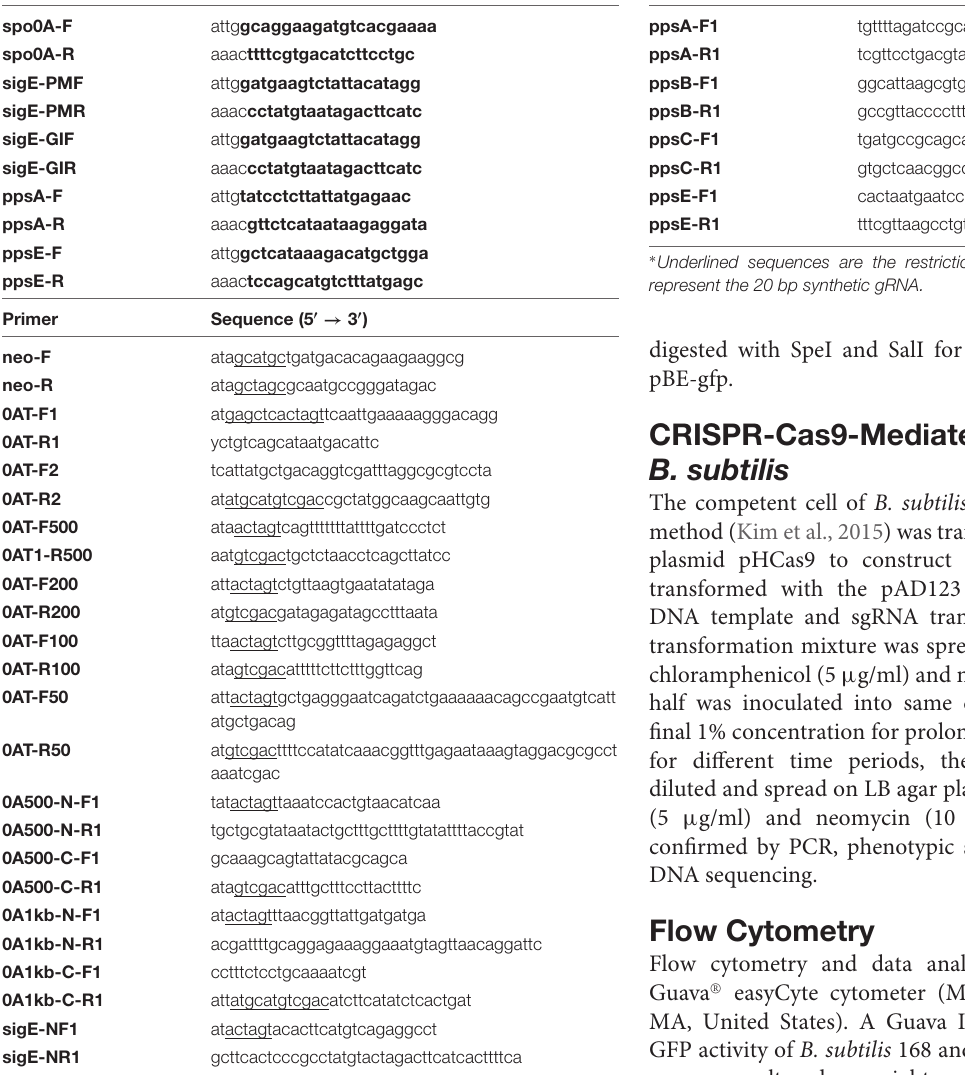
TABLE 2 | Oligonucleotides and primers used in this study.